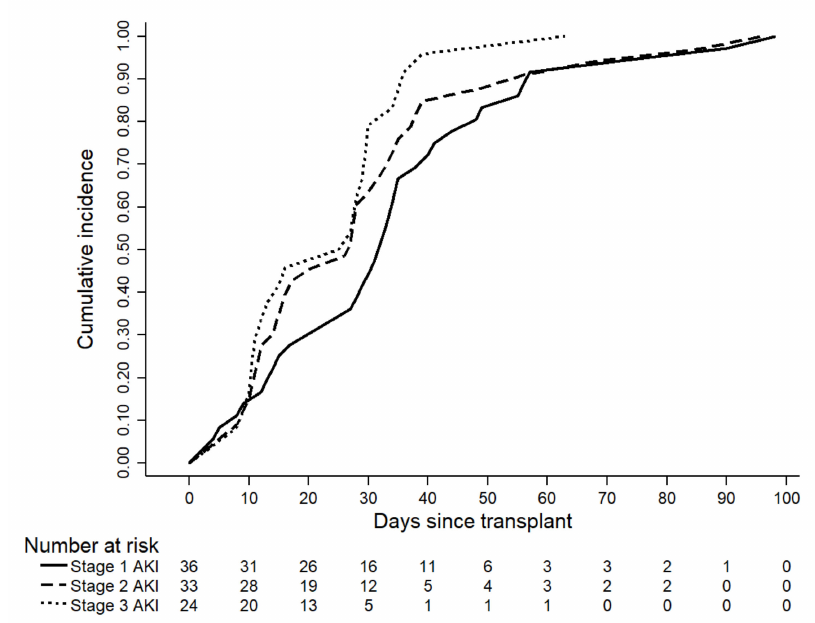
Figure 1. Kaplan–Meier curves for the cumulative incidence of AKI according to its